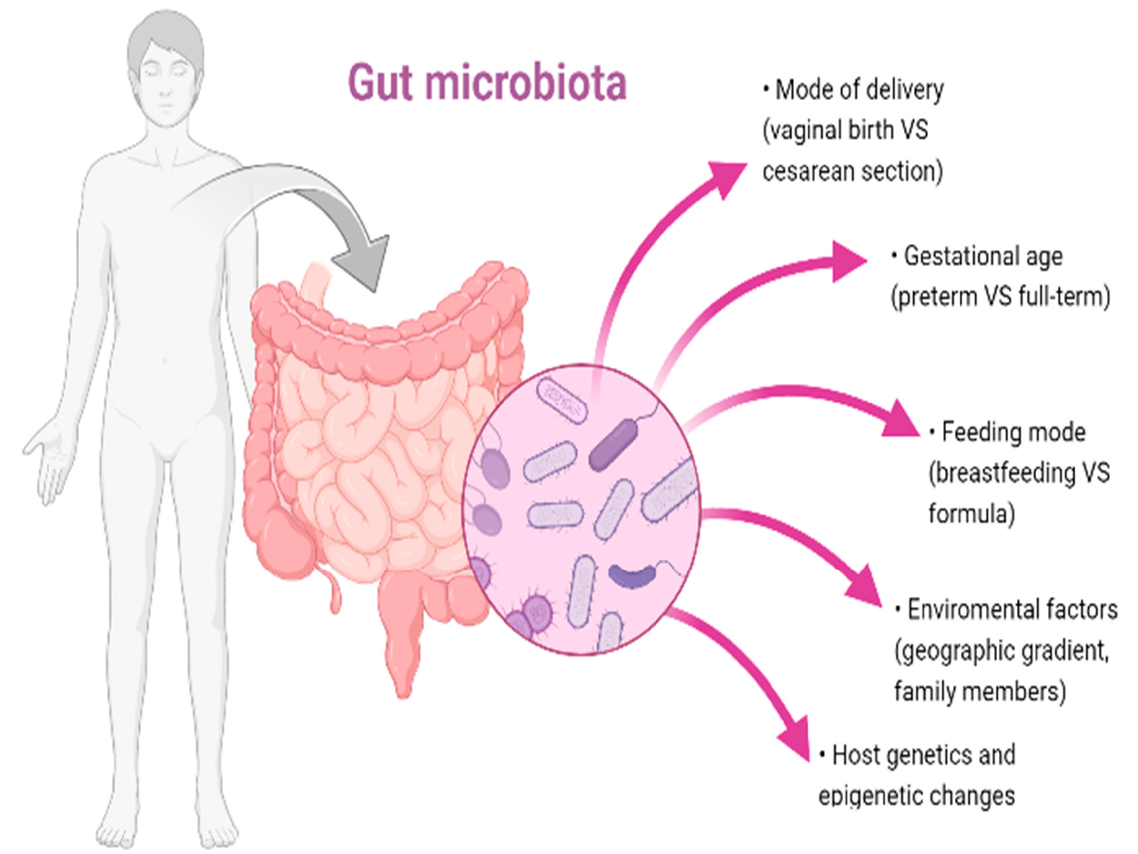
Figure 1. Factors that affect gut microbiota establishment.